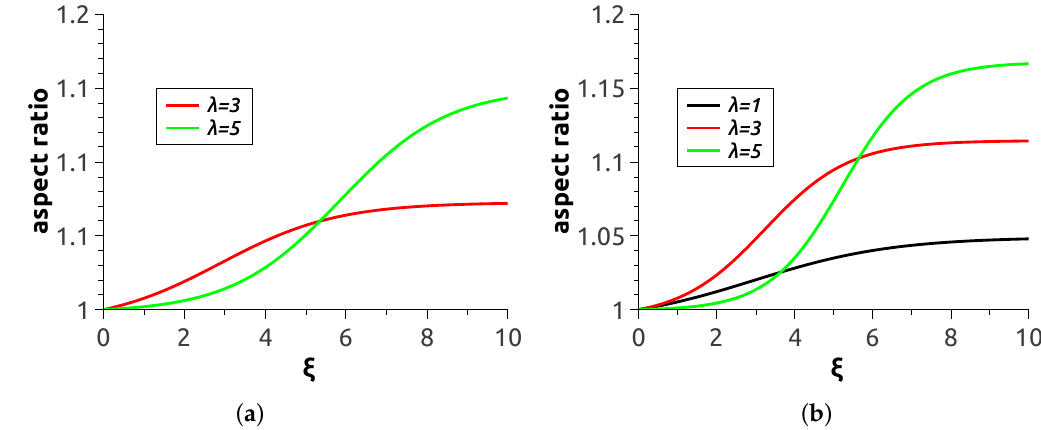
Figure 5. Field strength dependence of the aspect ratio of an MPS under variation of the external field, ( a ) magnetic particle volume fraction φ = 5.5vol.%; ( b ) magnetic particle volume fraction φ =